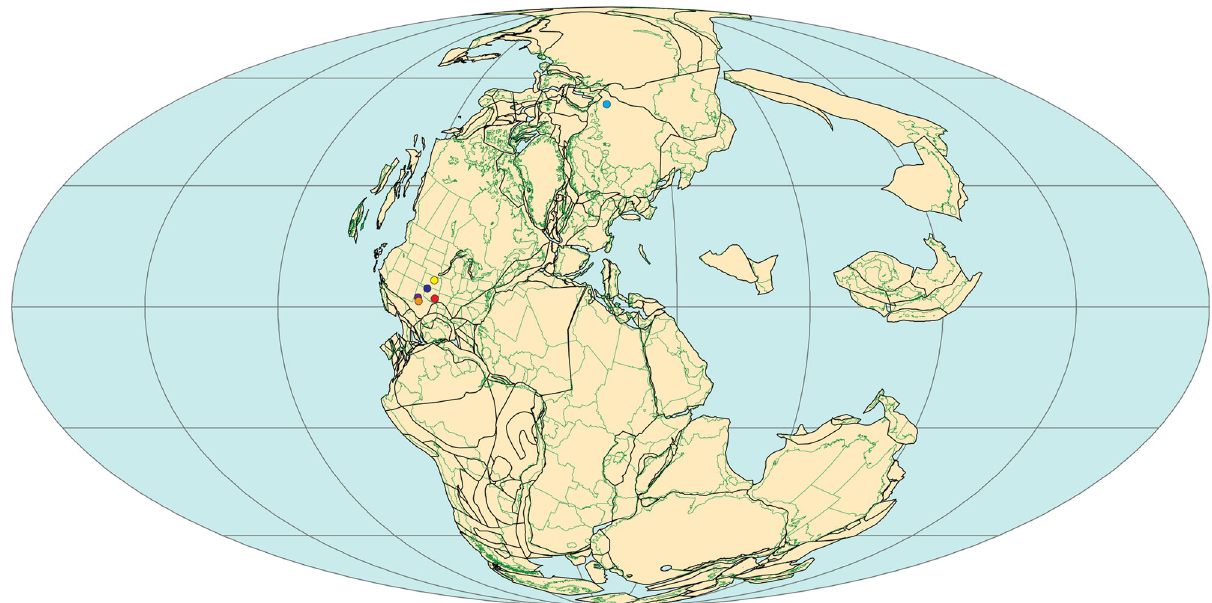
Fig.6|PaleogeographicdistributionofthefossiltaxainLatePaleozoicPangea. The amniotes Mesenosaurus, Oromycter , Opisthodontosaurus, Captorhinus, Delor- hynchus, Colobomycter , and the stem amniote Seymouria were collected at the Dolese quarry, Richards Spur, Oklahoma, USA (red dot); the varanopid Watongia wasfoundinBlaineCounty,Oklahoma(bluedot);thesphenacodontid Dimetrodon wascollectedatBriarCreekBonebed,while Edaphosaurus wasfoundatHogCreek,